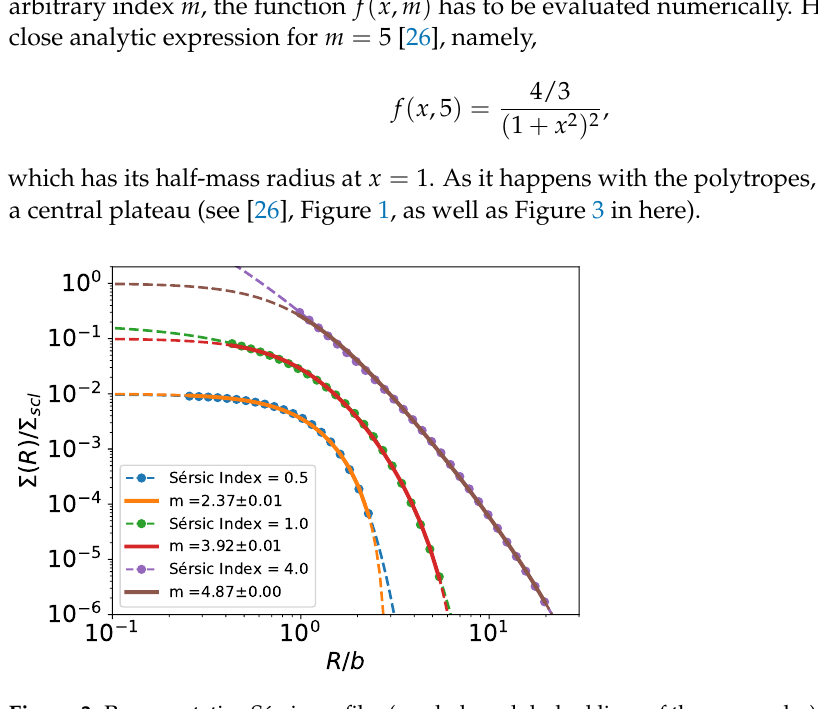
Figure 3. Representative Sérsic profiles (symbols and dashed lines of the same color) fitted with propol